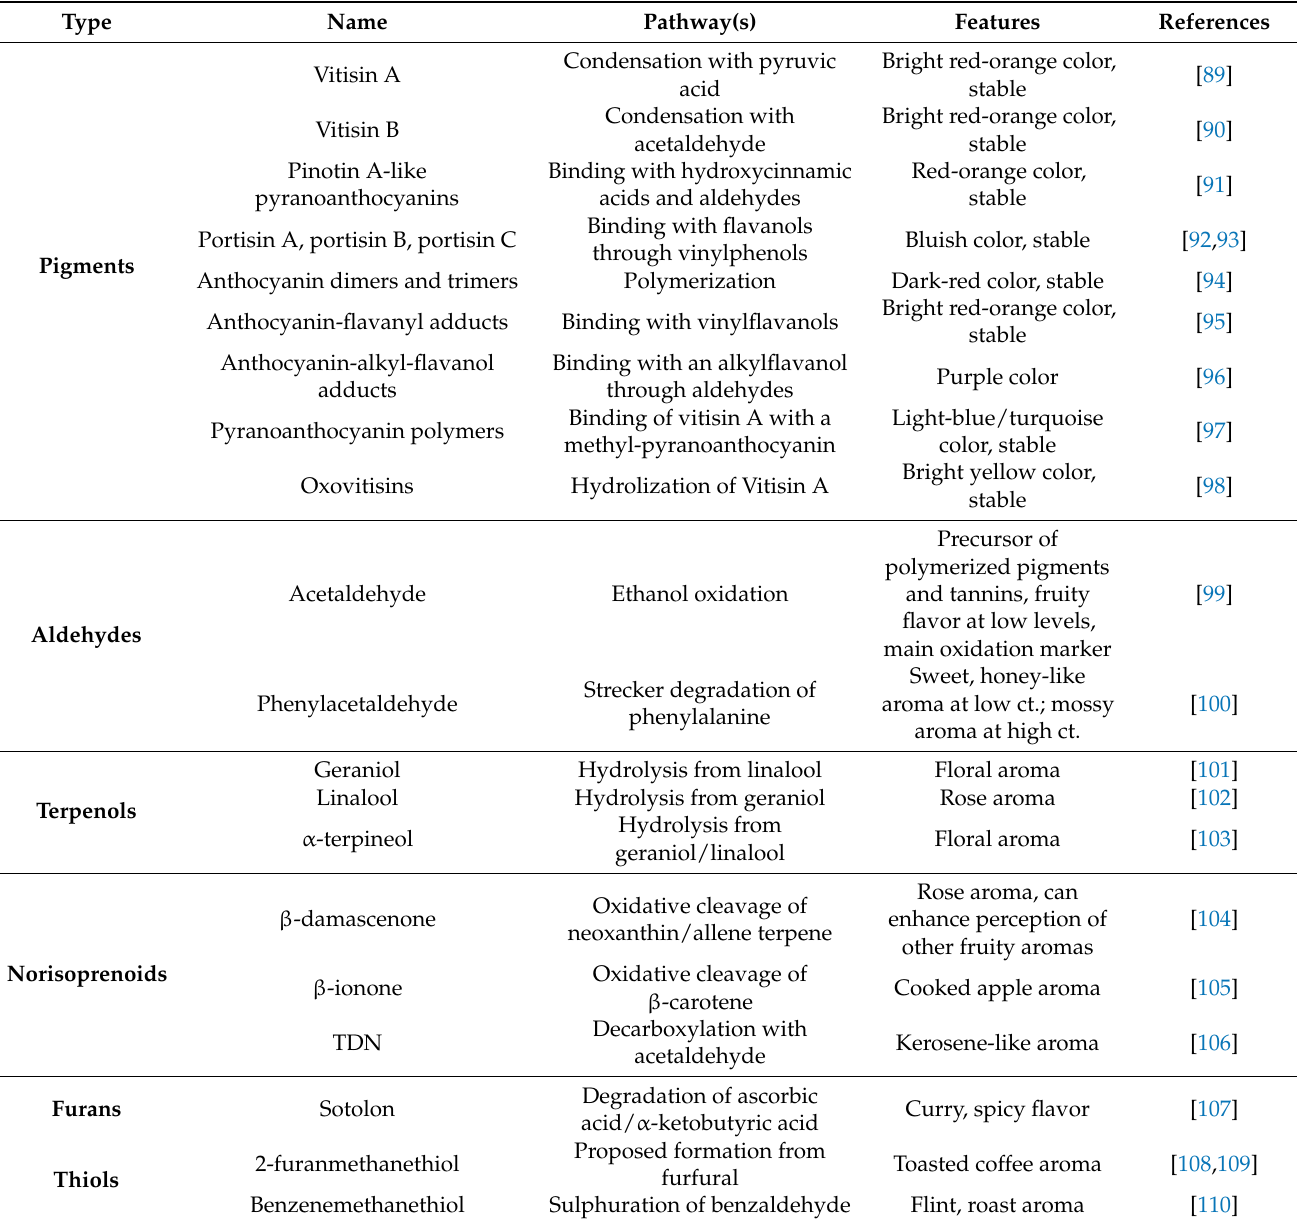
Table 2. Major compounds of interest produced during bottle